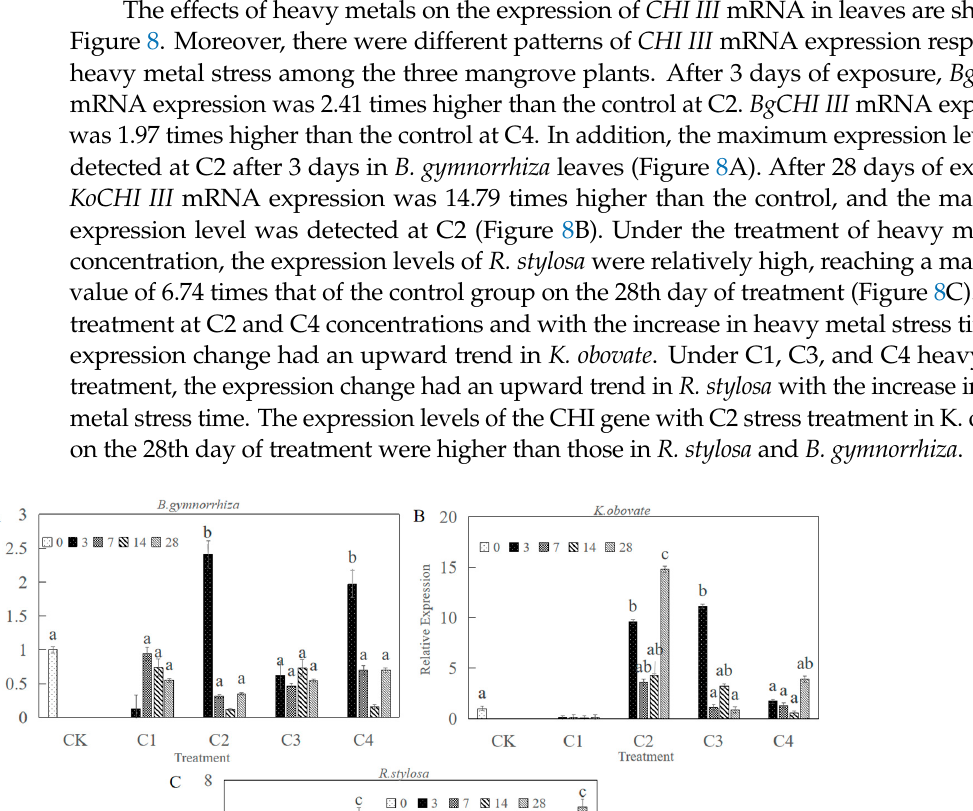
Figure 7. Effect of heavy metal treatments on H 2 O 2 content of mangrove plants. Data are the means ± standard of three separate individuals. Each bar with different lowercase letters was significantly different ( p < 0.05).